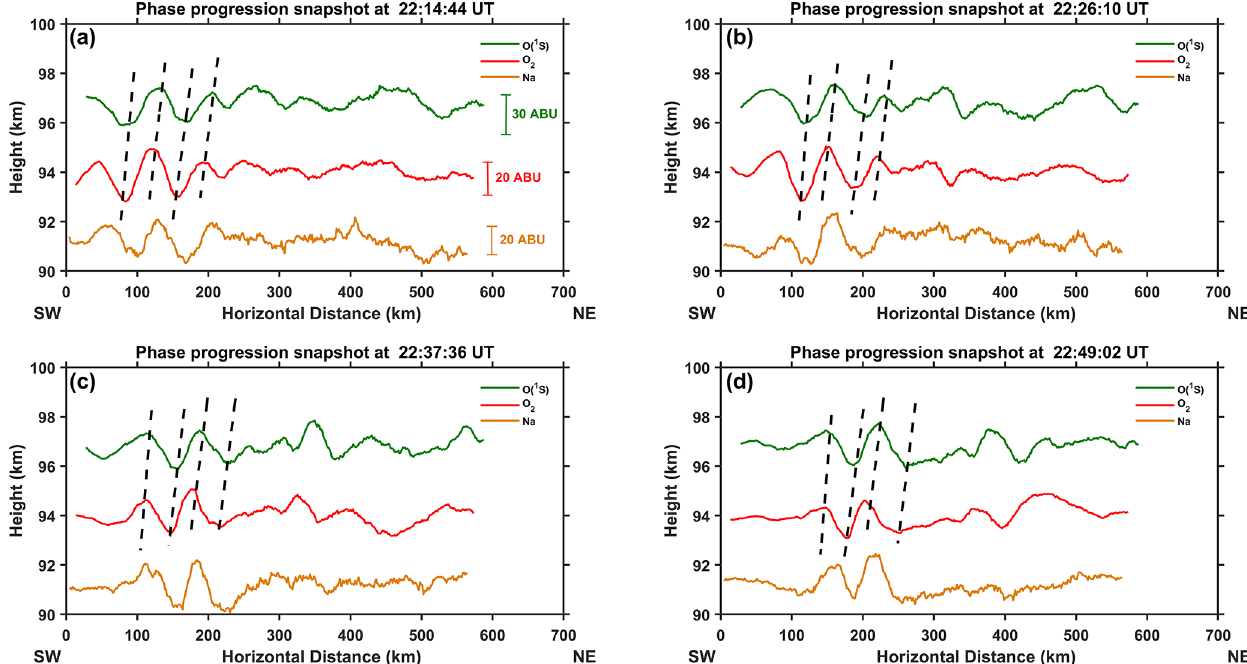
Figure 6. (a–d) The green, red, and orange solid lines in each panel depict the wind shear corrected intensity variation of O( 1 S), O 2 , and Na airglow emissions, respectively, along their line of propagation. The slices have also been horizontally shifted using the intrinsic horizontal wave speed in order to make a quasi-simultaneous “snapshot” of the vertical structure of the wave field. The slices have been separated vertically in order to represent the relative vertical separations of the emission layers in the MLT region. The emission brightness is given in arbitrary brightness units (ABU) in panel (a) and refers to all four panels.